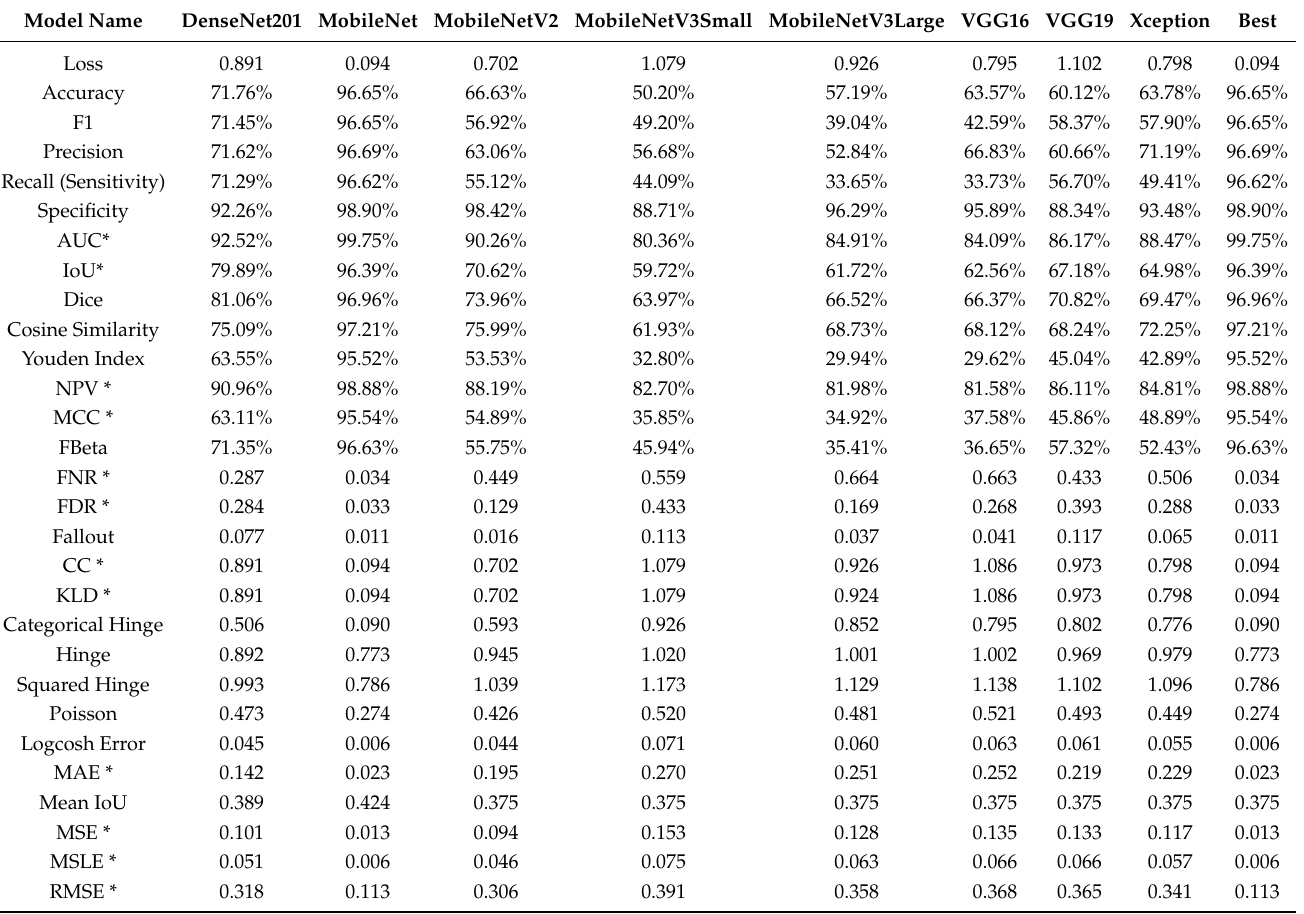
Table 4. The best performance metrics reported by the “Alzheimer’s Dataset (4 class of Images)”